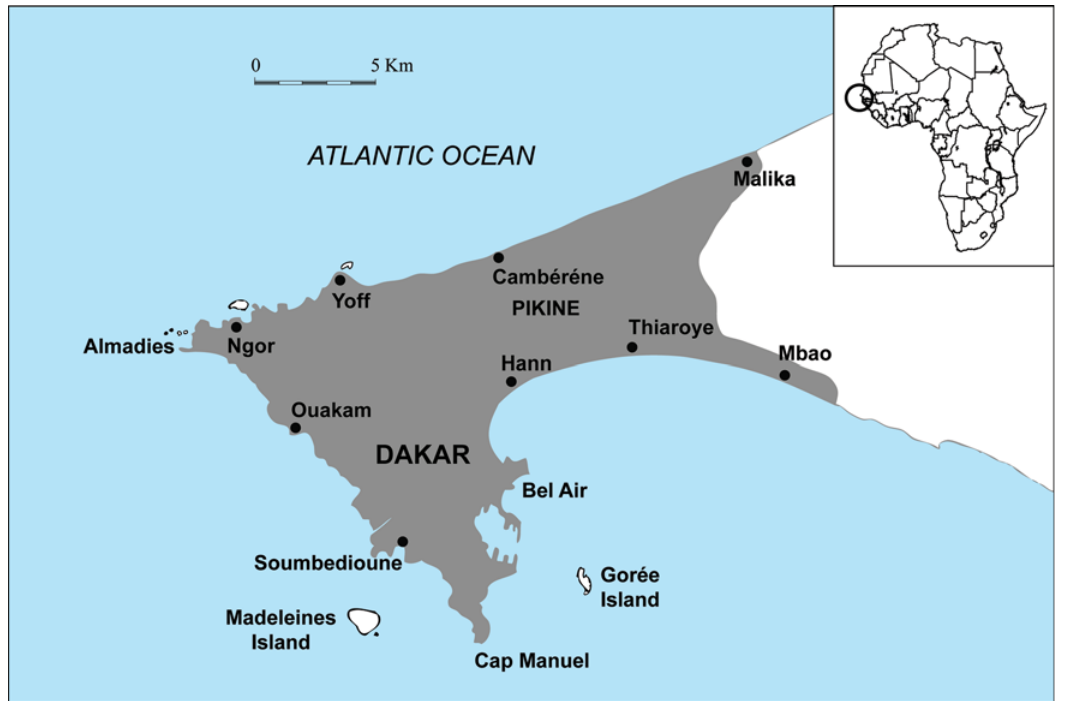
Figure 1. Map of Cap Vert peninsula, Senegal.